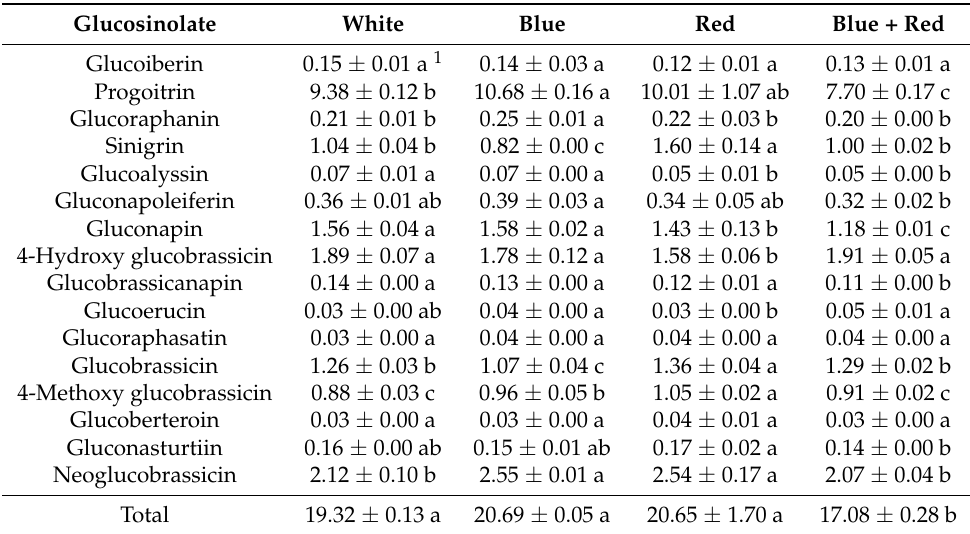
Table 1. The accumulation of glucosinolates (mg/g dry wt.) in Brassica napus sprouts grown under different LED lights.